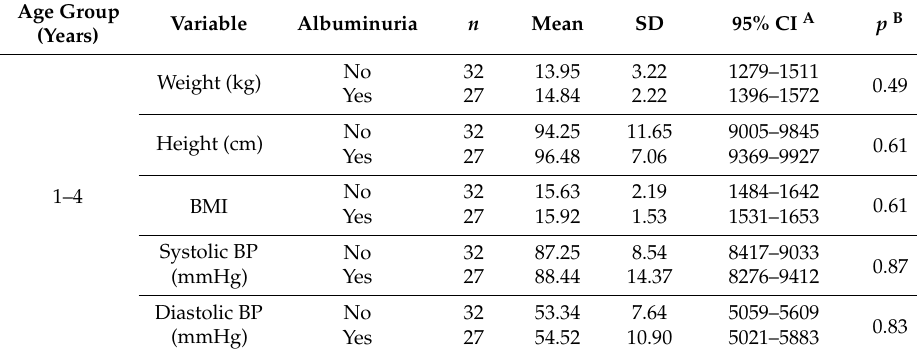
Table 2. Data related to height, weight, BMI, and blood pressure in children with albuminuria positive and negative